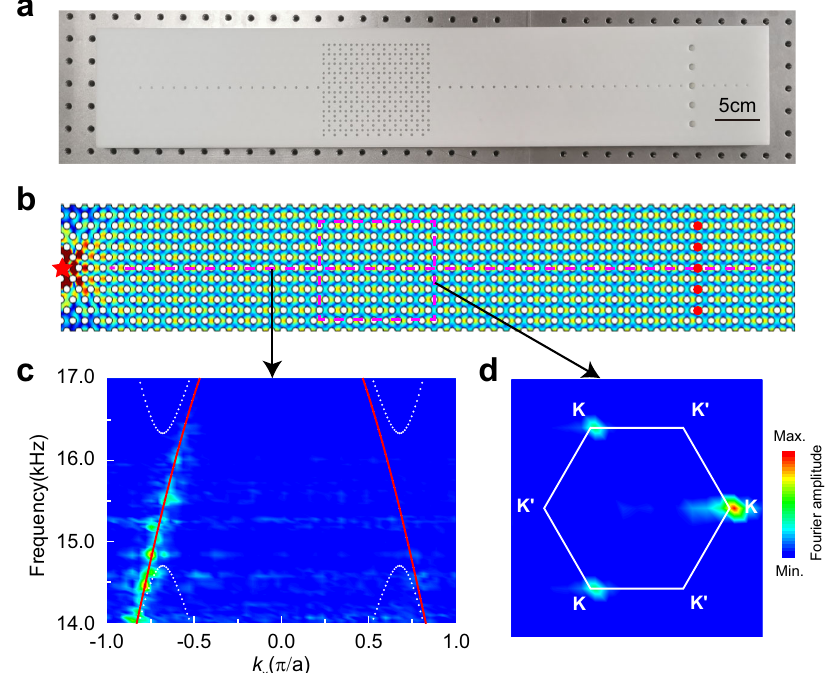
Fig. 2 | Experimental measurement of the CABSs. a Photo of the sample. b Simulated acousticpressure fi elddistributions at 15.5kHz for apoint source (red star) on the left of the straight PC. c Experimentally measured dispersions (colors) compared to the simulated dispersions (white dots and red lines). d Experimental